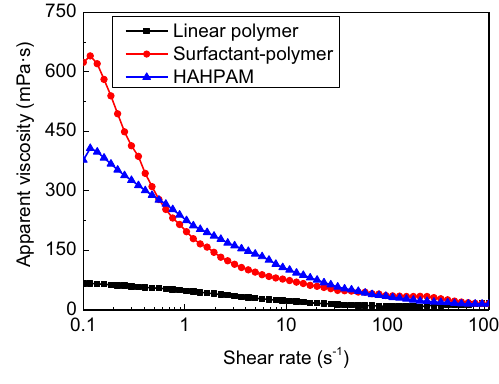
Fig. 6 Apparent viscosity plotted as a function of 0.2 wt% lin- ear polymer, 0.2 wt% surfactant–polymer, and 0.2% HAH- PAM polymer, Cp = 0.2 wt%. (salinity = 9000 mg L −1 , [Ca 2+ ] + [Mg 2+ ] = 900 mg L −1 , ̇𝛾 ranges from 0.1 to 1000 s −1 ). Both the aging and measuring temperatures are 65